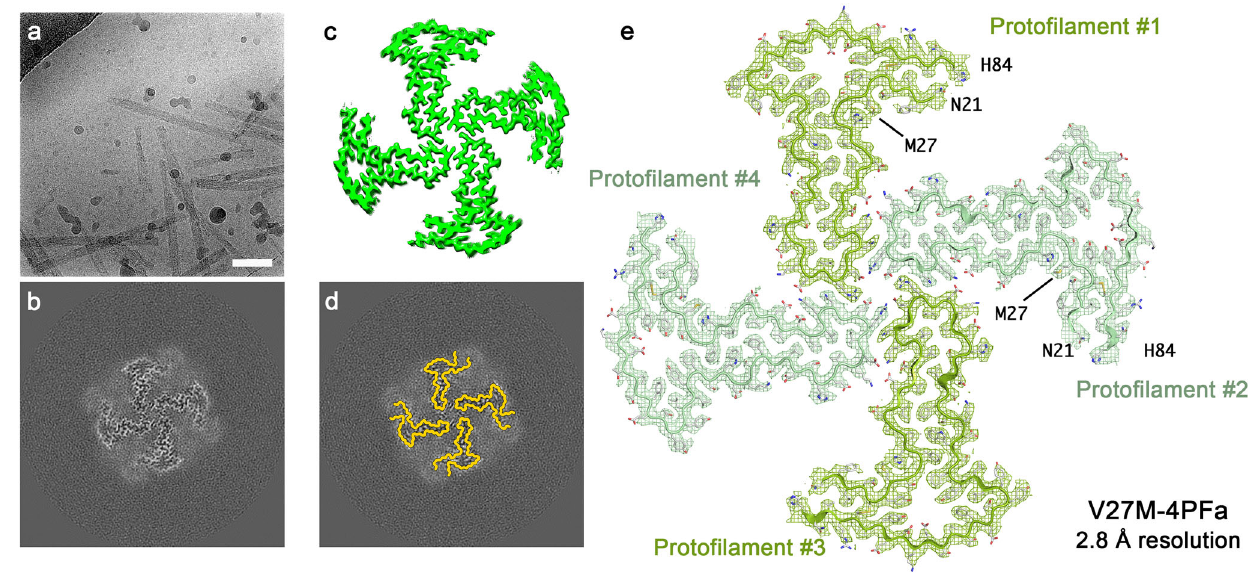
Fig. 5 | Polymorphism in β 2 m-V27M fi brils. a Raw cryoEM micrograph of fi brils (scale bar corresponds to 50nm). Two independent experiments β 2 m-V27M were performed, with similar results. b Cross-section through the 3D reconstruc- tion of the four proto fi lament polymorph found in the β 2 m-V27M dataset that could be processed to high resolution. As in Figs. 2 and 4, this cross-section represents the sum of the reconstructed densities for six XY-slices, equivalent to one rung of the amyloid fi bril. c Surface representation of the same structure in